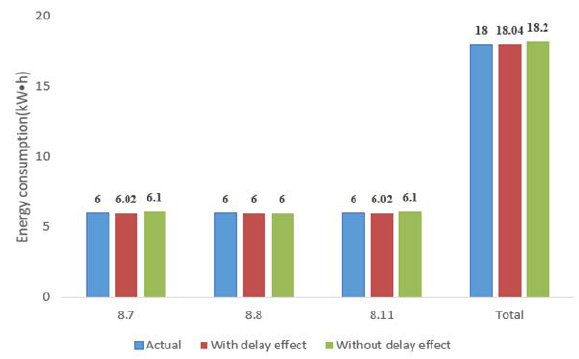
Figure 9. Comparison between simulated energy consumption and actual energy consumption of water pumps.